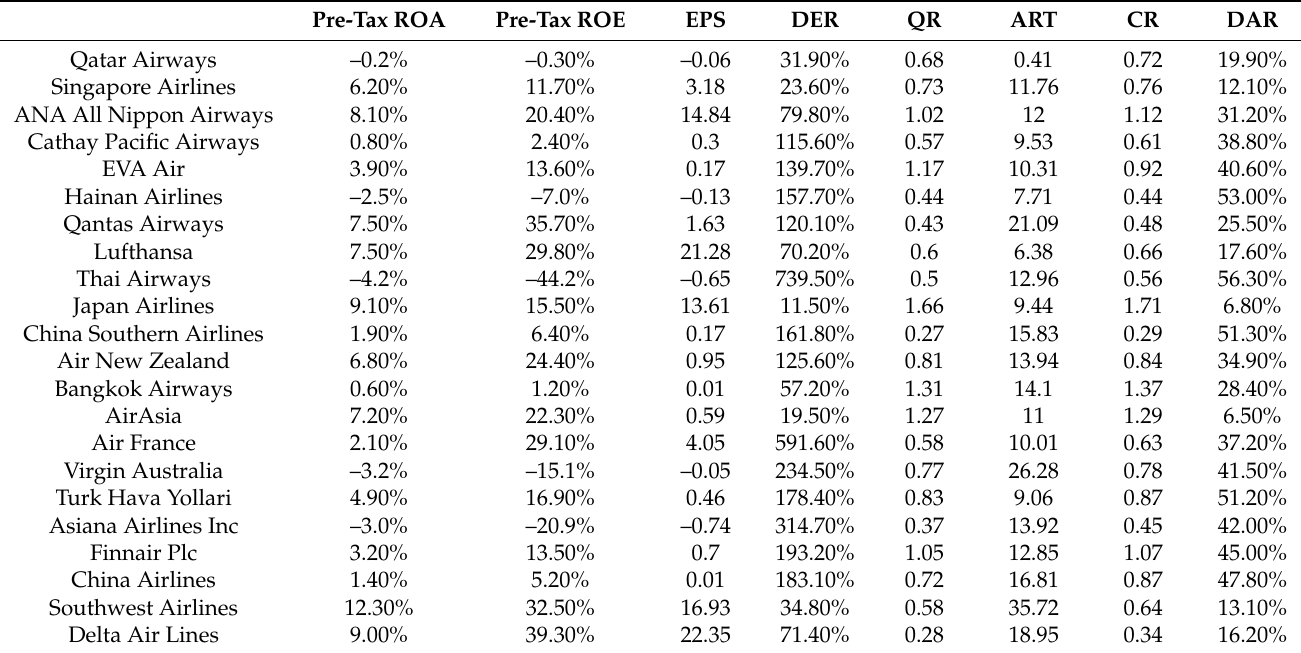
Table 3. Original data matrix (for 2018).